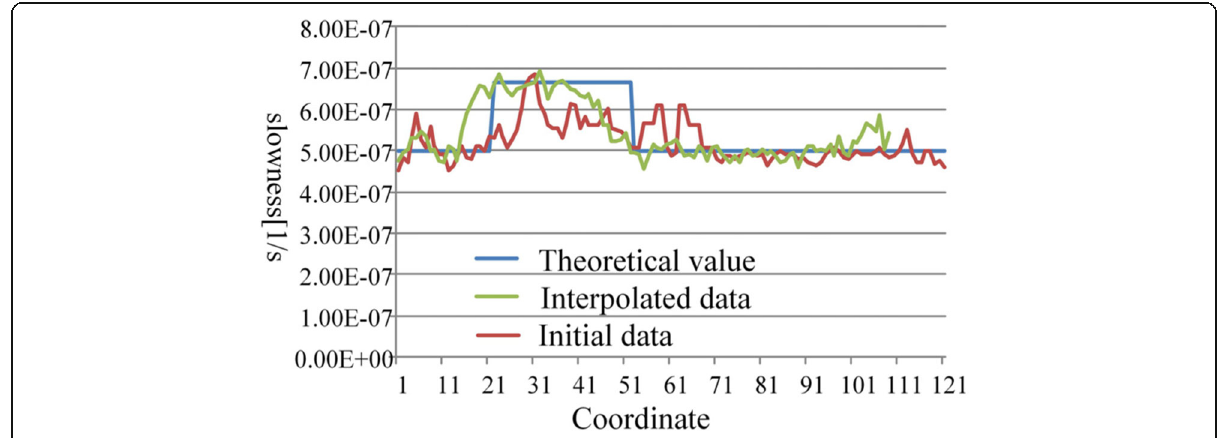
Fig. 7 The profile of distribution of reconstructed